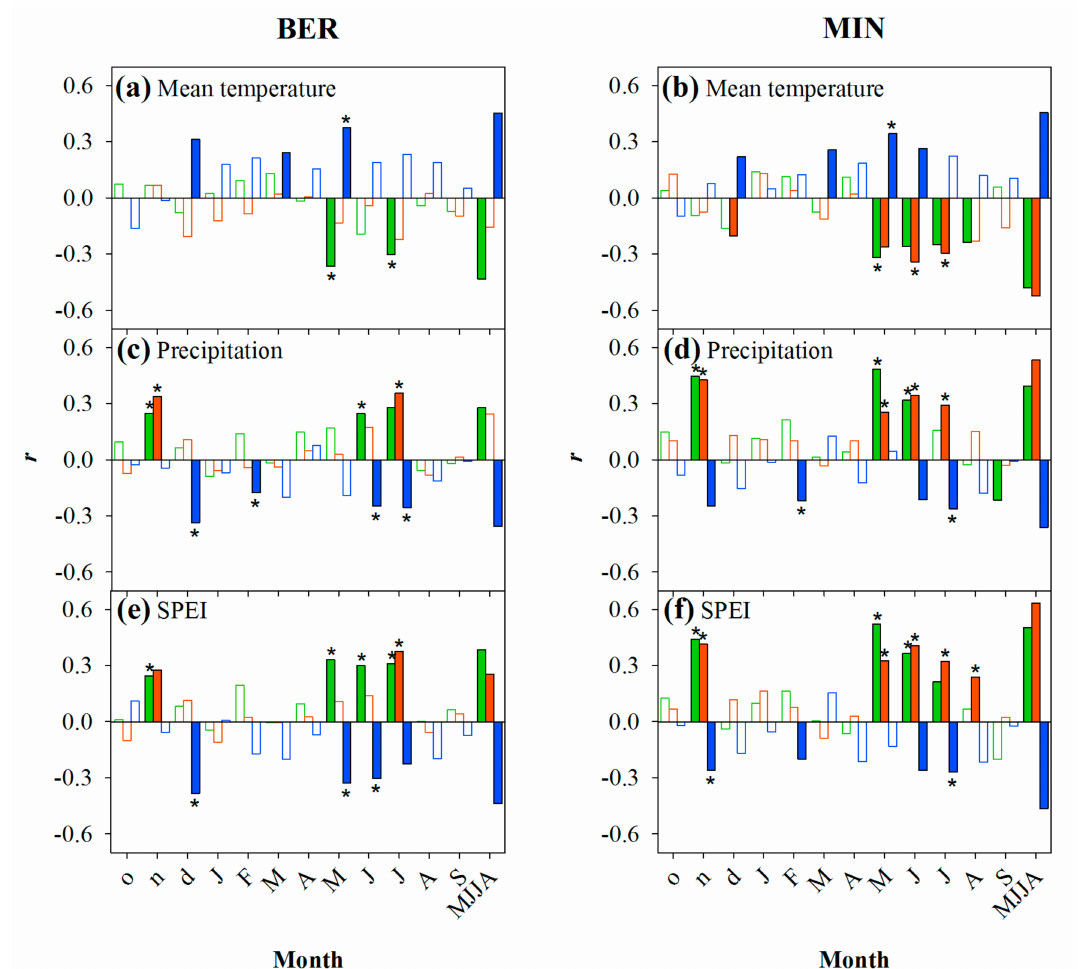
Figure 4. Tree responses to climate in BER (left panels) and MIN (right panels) for the period 1940–2014. The relationships with climate are based on bootstrapped correlations and response function partial regression coefficients between indexed tree-ring data corresponding to each site and ( a , b ) mean temperature, ( c , d ) precipitation, and ( e , f ) Standardized Precipitation-Evapotranspiration Index (SPEI). Climate signals are investigated at monthly and seasonal (May–August) time scales. Significant correlation and partial regression coefficients ( p < 0.05) are indicated by filled bars and asterisks, respectively. Tree-ring traits are represented in green (TRW i ), orange ( ∆ 13 C i ), and blue ( δ 18 O i ). Lowercase and uppercase letters in the x -axes correspond to months of the years before and during tree-ring formation,